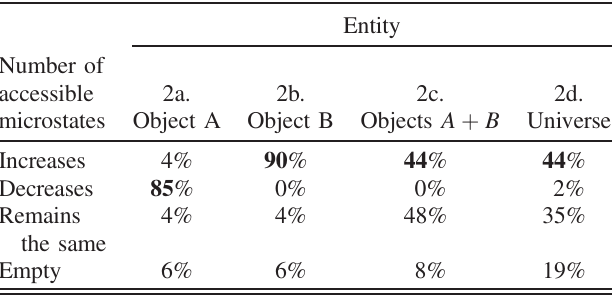
TABLE III. Percentages of students ’ categorized responses in the items addressing the microscopic nature of entropy and the second law of thermodynamics. The percentage of correct responses is shown in boldface N ¼ 48